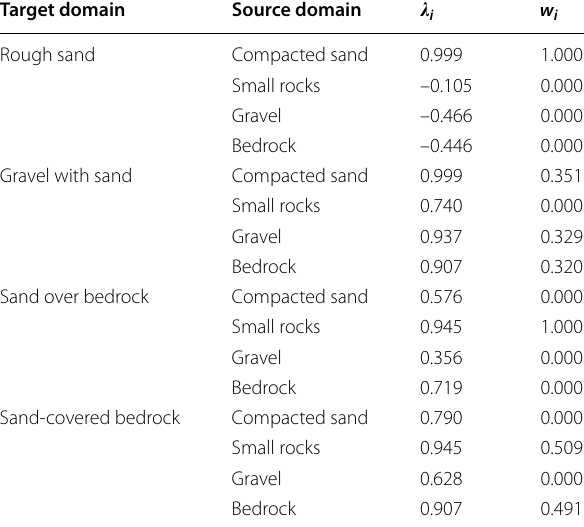
Table 5 RMSEs and KLDs of power consumption models learned based on MS-TGPR in Evaluation 5